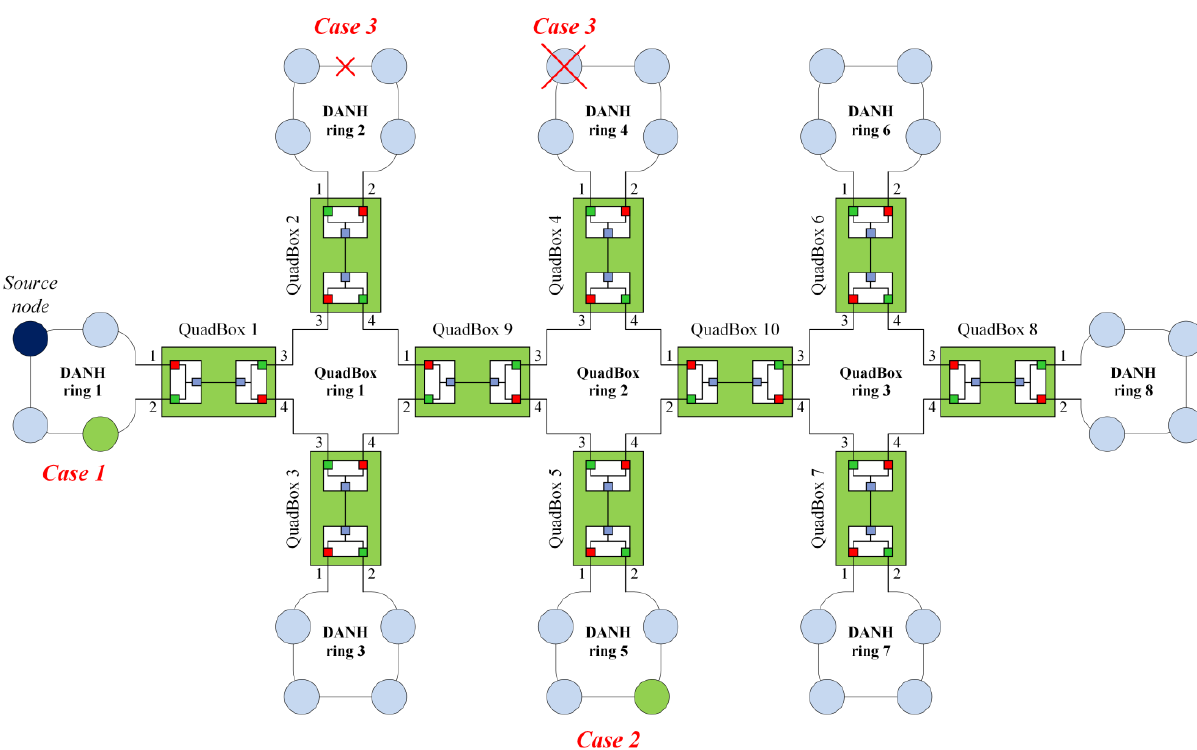
Figure 10. A sample high-availability seamless redundancy (HSR) connected-ring